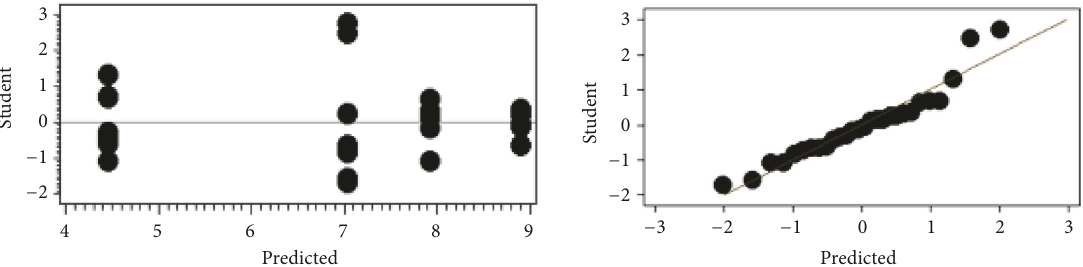
Figure 3: Plots of studentized residuals versus predicted values and versus normal quantiles for dry mix.